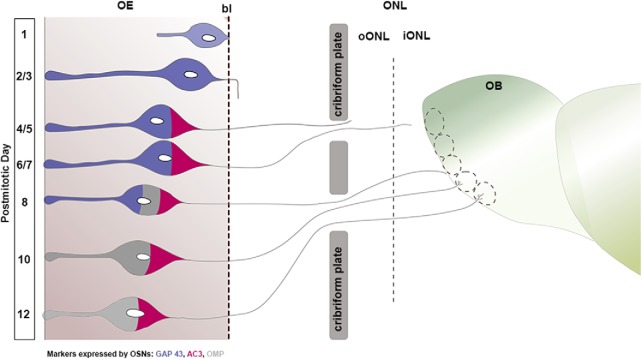
Schematic integrating three aspects of the OSN maturation process based on a compilation of postmitotic data following both the BrdU and 4OH-Tx protocols at P25: (1) cell body radial migration in the OE; (2) differential marker expression; and (3) axon extension from the OE to the OB. Cell morphology changes; expression of GAP 43 (blue), AC3 (maroon), and OMP (gray); and axonal extension progress are correlated with the corresponding postmitotic day. P25-born OSNs extend their apical dendrite and reach the OE surface 2/3 d following mitosis; simultaneously, they extend their axons deep in the basal lamina and express GAP 43; 4 and 5 d after basal cell division, axons cross the cribriform plate and reach the oONL, at which stage cells express AC3; 1/2 d later, axons innervate the oONL and iONL broadly. OSNs express OMP by postmitotic day 8, and, concurrently, their axons reach the GL, ramifying themselves into the glomerular neuropil from day 10 following basal cell division onward. Black dashed line represents the basal lamina. bl, Basal lamina; GL, glomerular layer.